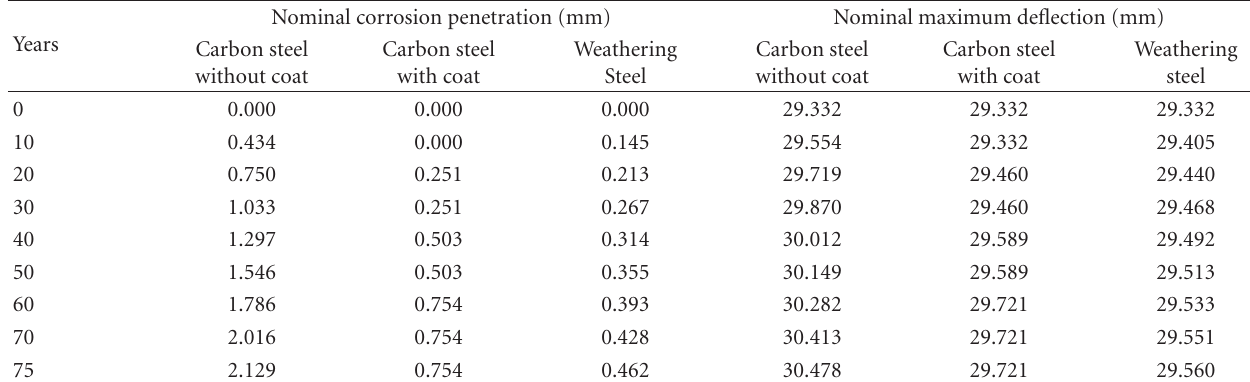
Table 6: Deflection of steel girder bridge with cover